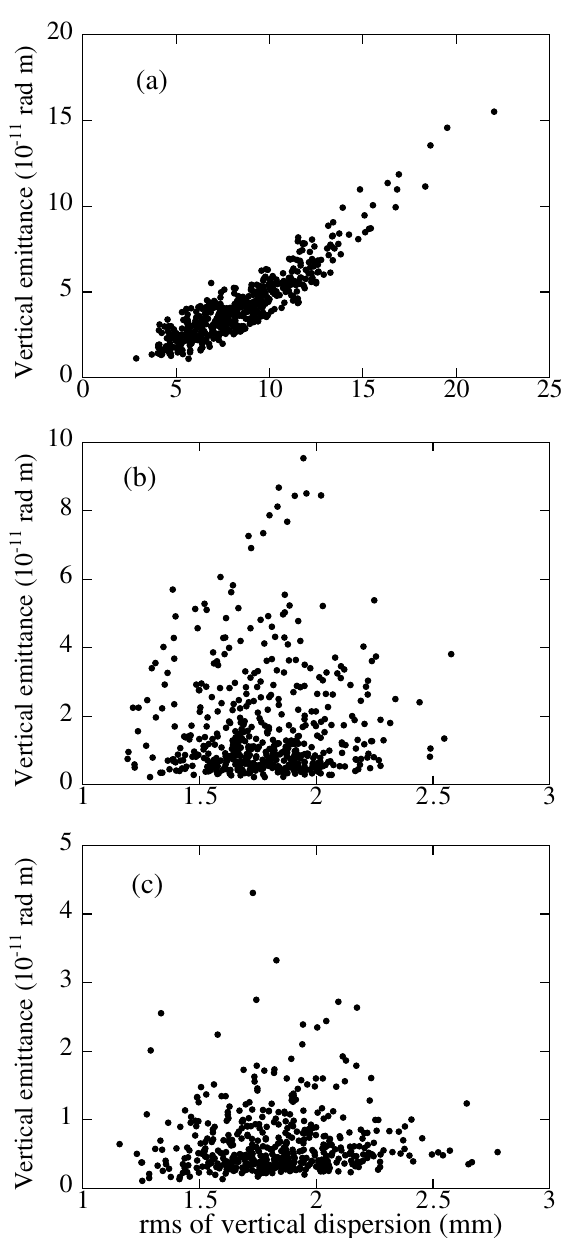
FIG. 6. (cid:26) vs (cid:3) (a) after COD correction, (b) after COD- y arc dispersion correction, and (c) after coupling correction.